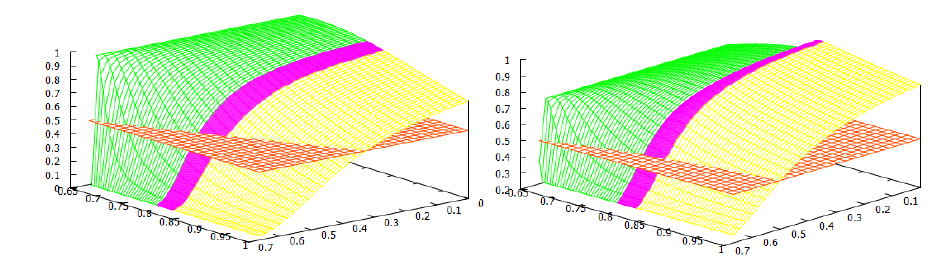
Figure 2. Left : The Nash welfare share ShW N of country X j . See Equation